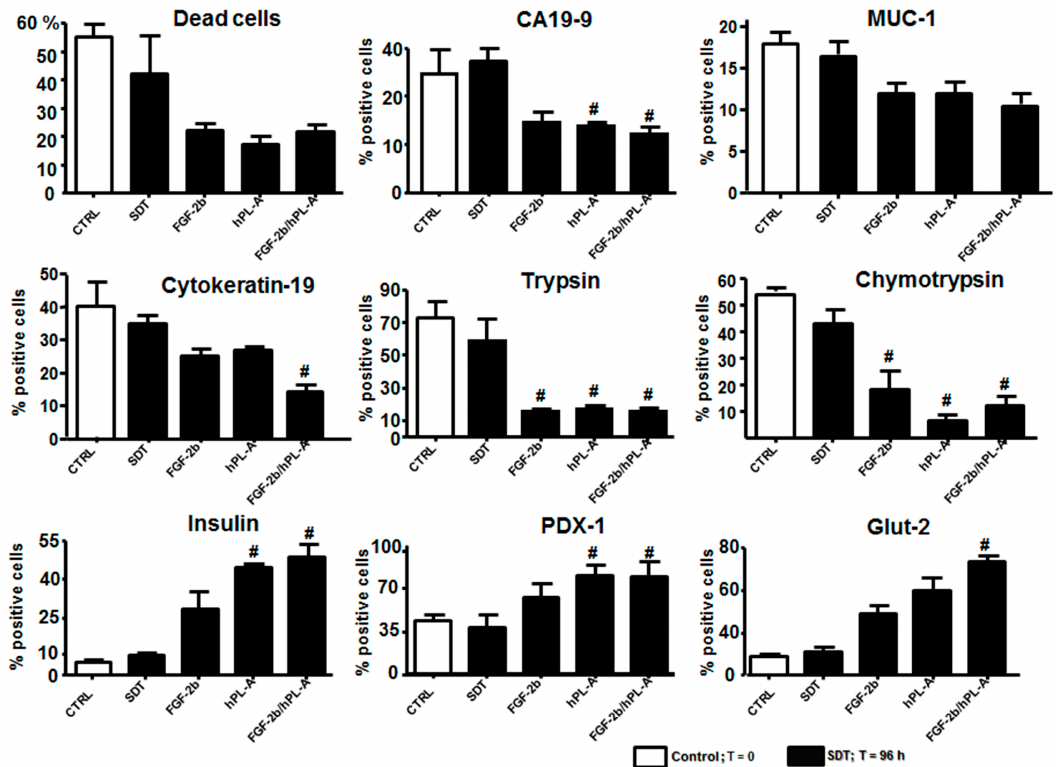
Figure 5. Cytofluorimetric analysis of islet-like aggregates obtained from non-endocrine pancreatic cells isolated from healthy donors. Non-endocrine pancreatic cells obtained from healthy donors after the procedure for islet isolation were immediately analyzed and then incubated with SDT alone, and SDT supplemented with 500 ng/mL FGF-2b, or 500 ng/mL hPL-A, or both hormones (FGF-2b plus hPL-A). Analysis was expressed as percentage of positive cells in association with the specific markers. After 48 h, stimuli were renewed and, following 96 h, aggregates were harvested and disaggregated into single cell suspensions. We performed the same panel of analyses before ( t = 0) and after ( t = 96 h) treatments: FACS for cell viability (propidium iodide) and for the expression of ductal markers Cytokeratin-19 and CA19.9, acinar markers chymotrypsin and trypsin, β cell markers insulin,